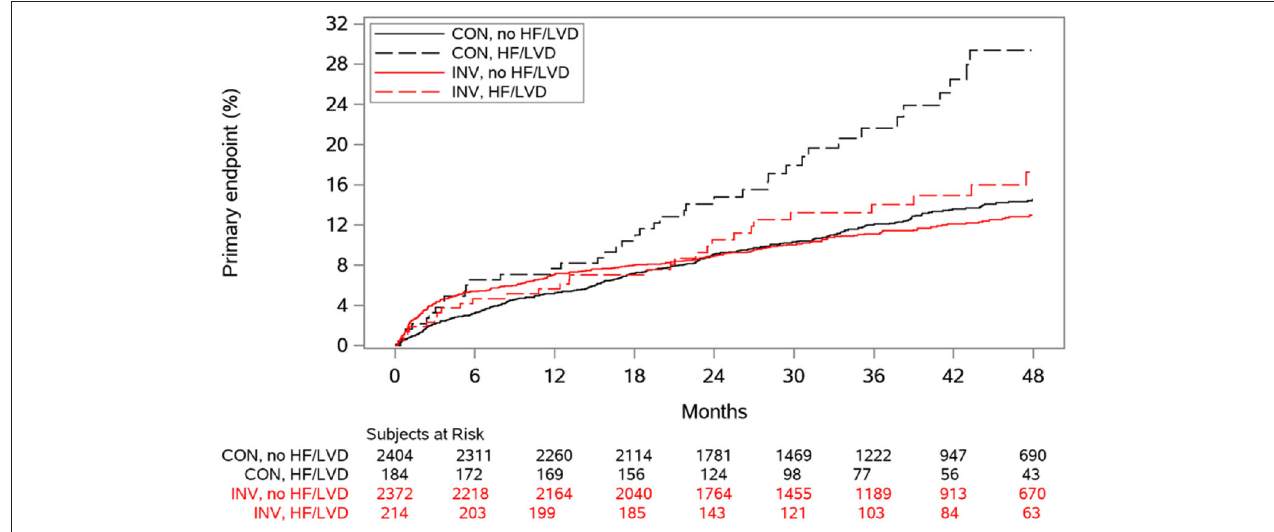
FIGURE 3 | Cumulative incidence curves for the primary composite outcome according to randomized treatment and history of heart failure (HF) or left ventricular dysfunction (LVD), from ISCHEMIA trial (52). CON indicates conservative strategy; and INV, invasive strategy.